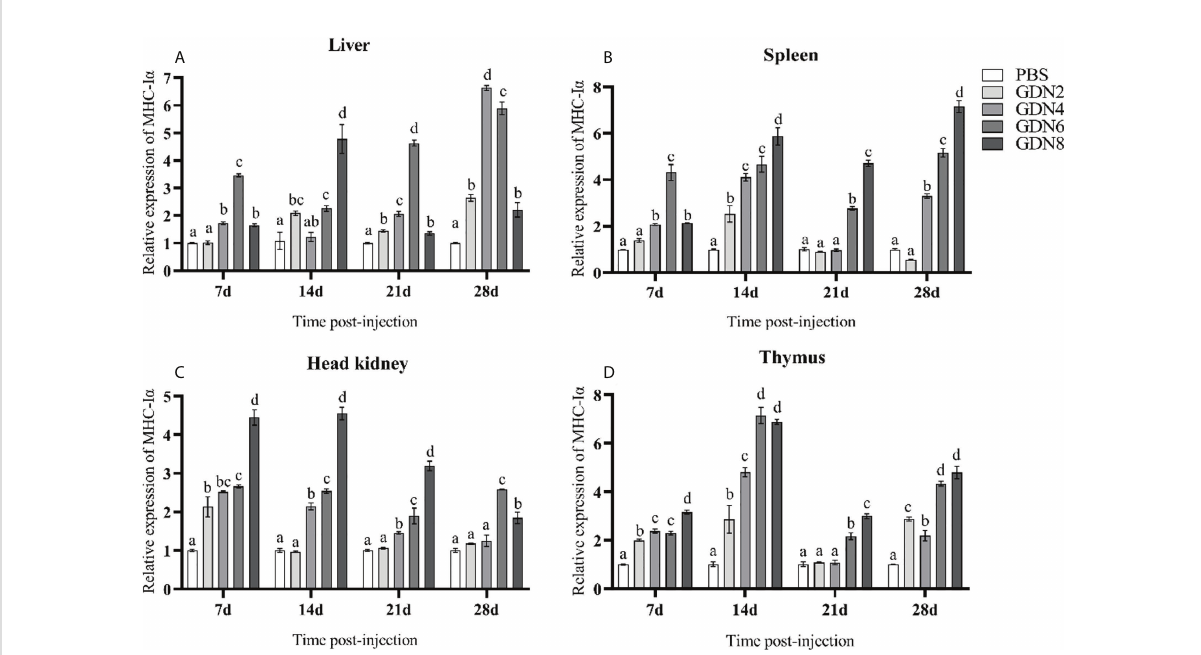
FIGURE 3 Expression levels of the MHC-I a gene in the four tissues of pearl gentian grouper ( A , liver; B , spleen; C , head kidney; D , thymus) by qRT-PCR post-injection. The mRNA levels of the MHC-I a gene were normalized to those of b -actin, and the relative expression levels were calculated. Signi fi cant differences ( p < 0.05) are marked by different letters (a – d).